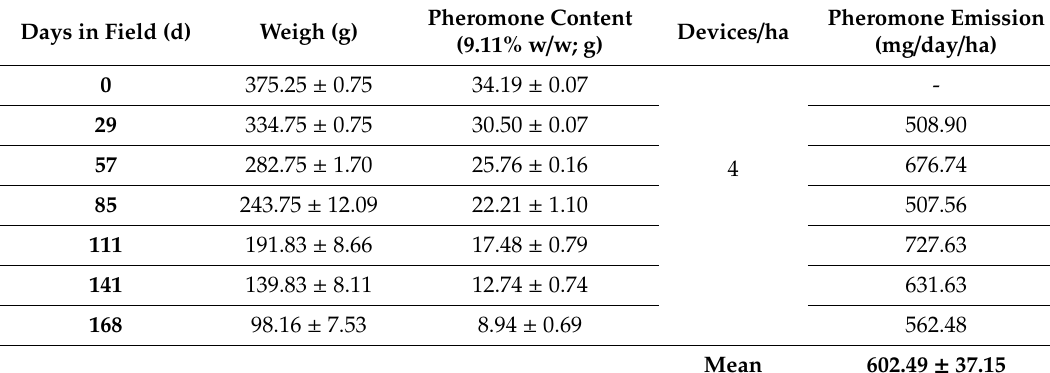
Figure 6. Pheromone release profile of Checkmate aerosol devices, as residual mean pheromone load (mg) contained in the dispensers vs. the time of field exposure (days). Release kinetics fitted the linear model given by the equation. Table 3. Checkmate aerosol devices pheromone content. Residual means of pheromone content (mg) throughout the time in field (days). Point values of Figure 6 and the total mean of pheromone used (mg/day/ha).